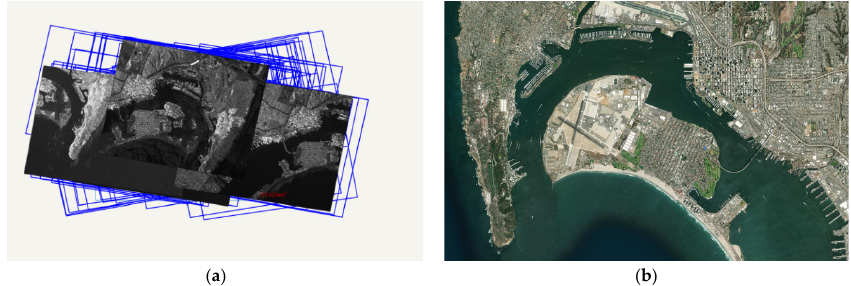
Figure 11. The GF3 repeated-observation dataset in San Diego. ( a ) The schematic diagram of repeated observation coverage area. ( b ) The Google optical image of this scene.